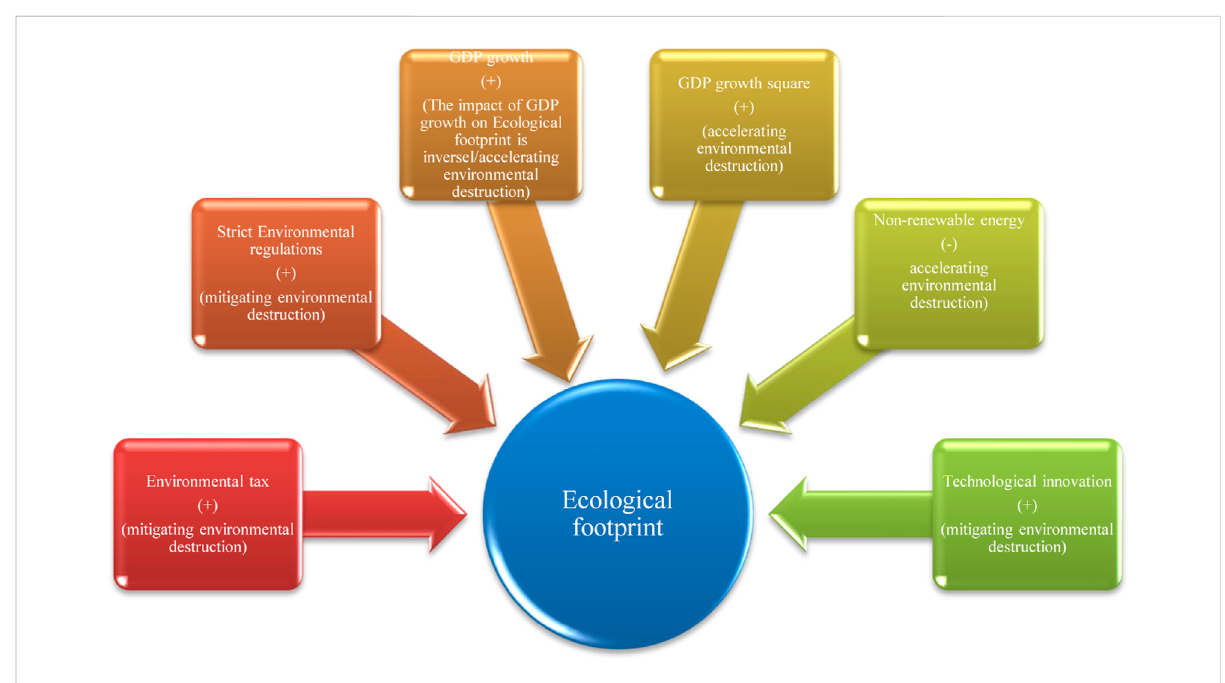
FIGURE 2 Graphical representation of statistical fi